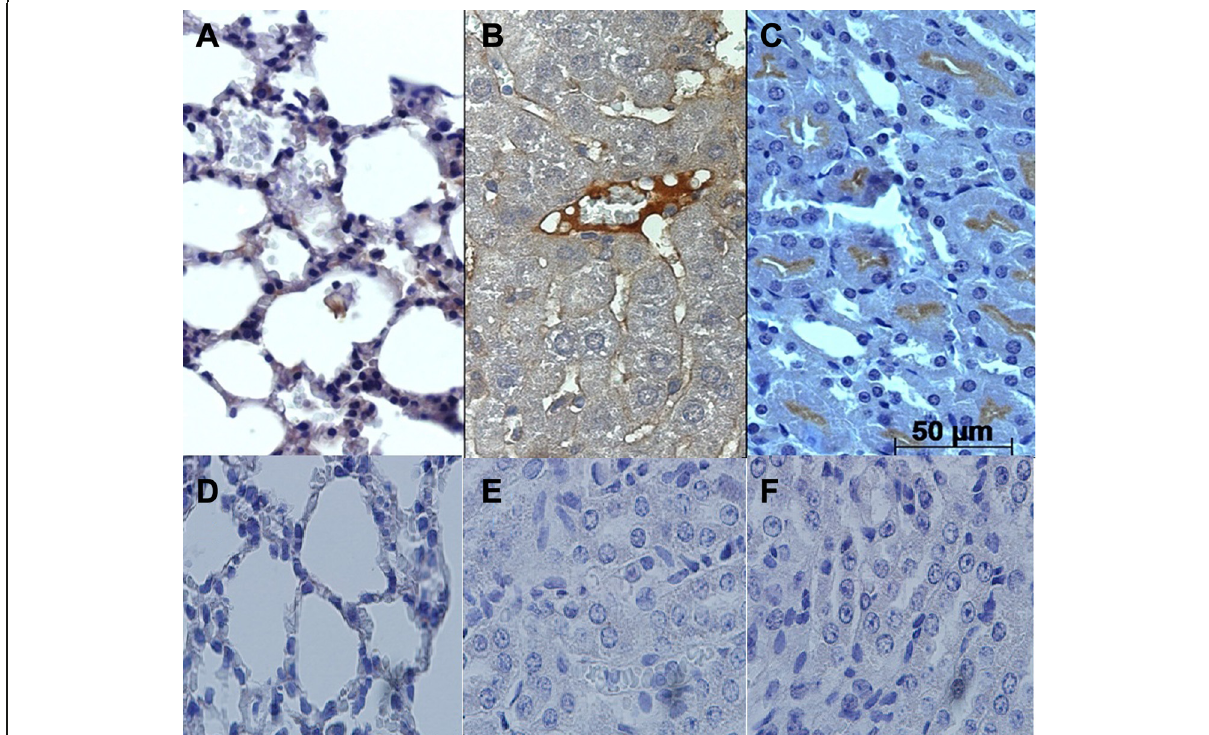
Fig. 2 Immunodetection of caspase-3 reactive cells in BALB/c lung, liver and kidney tissue infected with L. interrogans serovar Icterohaemorrhage. a Lung samples at 14 dpi revealed positive signals in the alveolar epithelium. b Liver samples at 14 dpi showed centrilobular vein endothelium reactive to caspase-3 antigen. c In the kidney, at 21 dpi, tubular epithelial cells positively labeled for caspase-3 were observed. ( d , e and f ). Lung, liver and kidney respective controls (n = 5